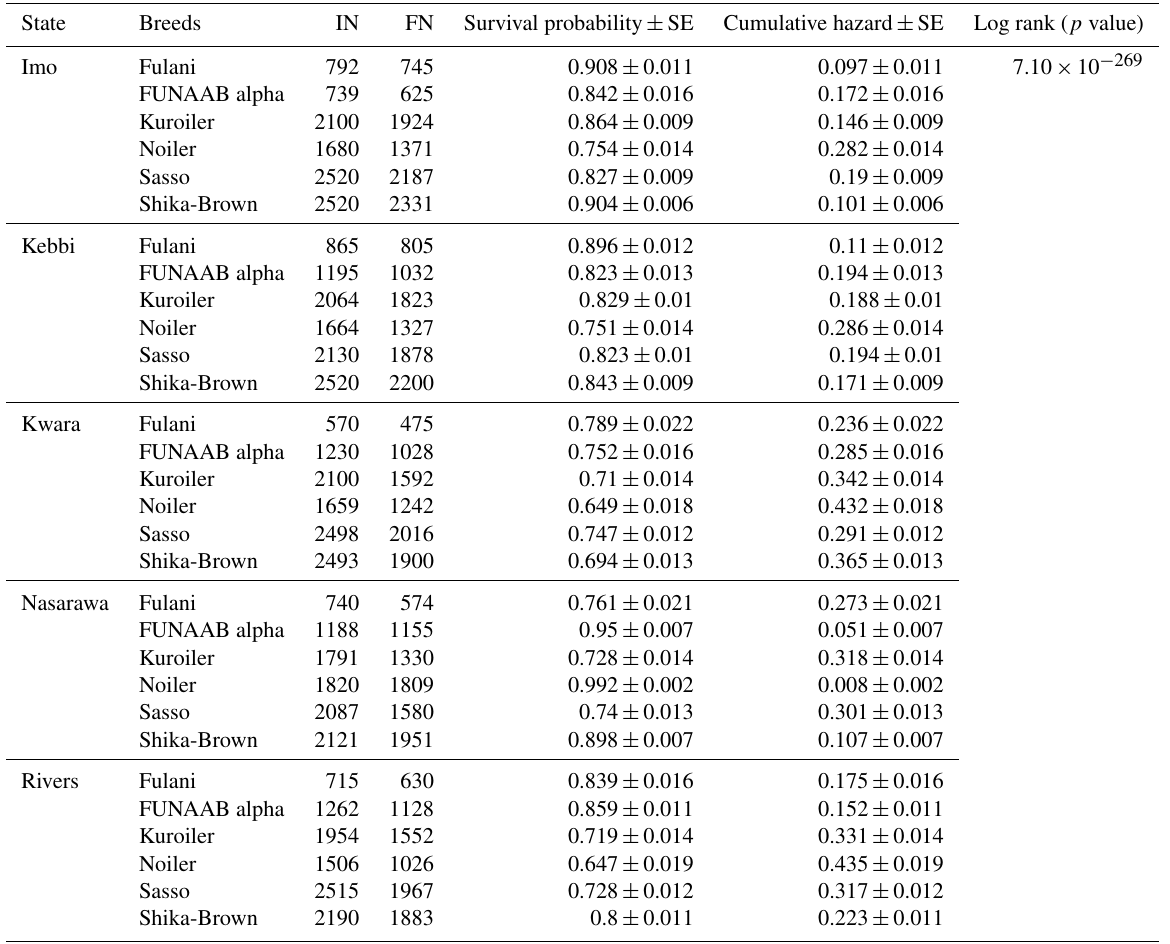
Table 12. Breed by environment interaction on survivability of birds (male and female) during growing in ACGG Nigeria project zones (6–18 weeks)